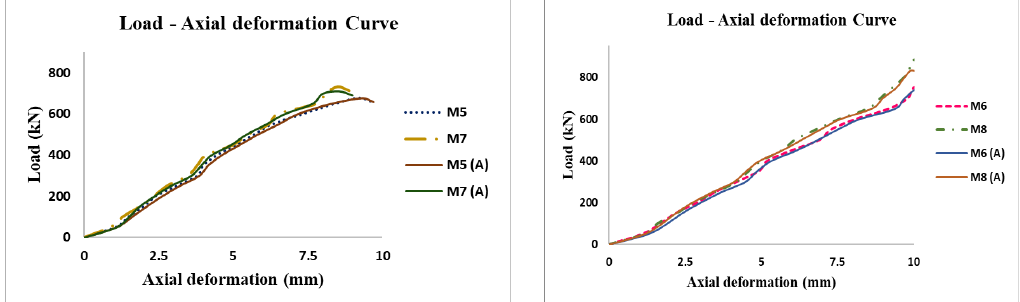
Figure 16. Load vs. axial deformation curves of self-stressed columns for the impact of expanding cement.